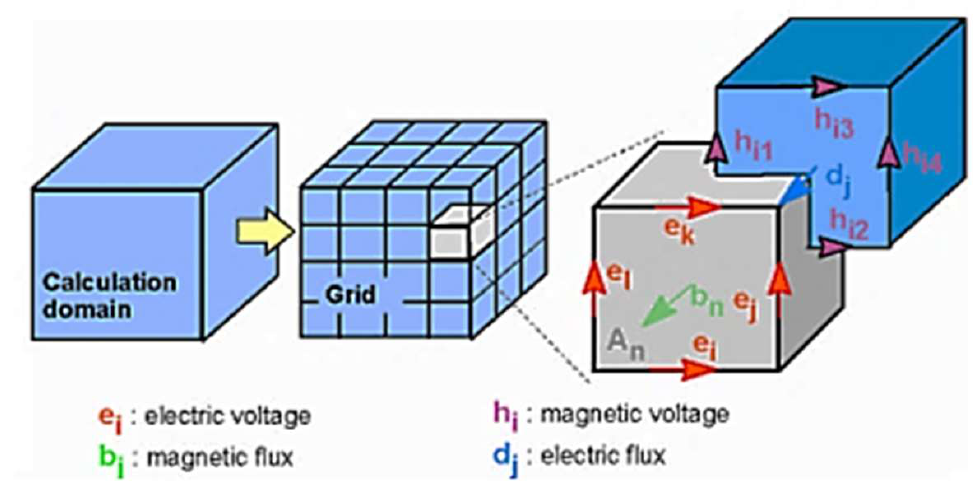
Figure 3. The mesh system of finite integration technique.